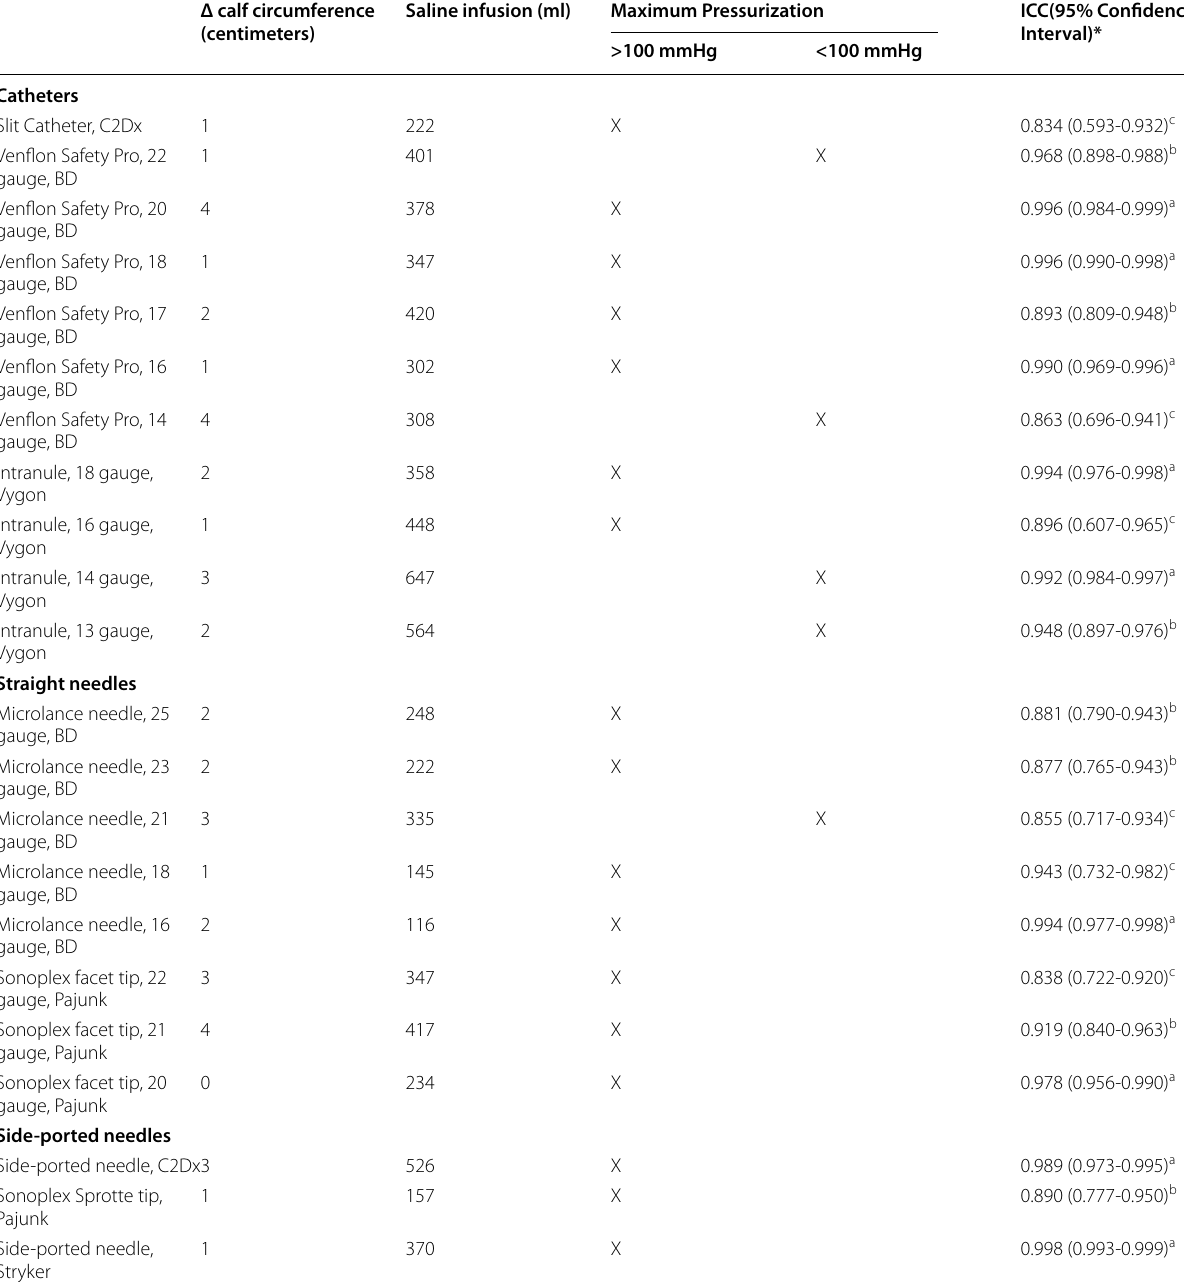
Table 2. Overview of change in calf circumference, the amount of saline infusion needed, the maximum pressurization, and the Intraclass Correlation Coefficient (ICC) with the respective confidence interval (CI) after running the decay model per needle type per post mortem human